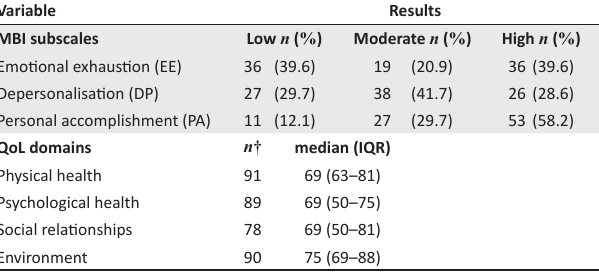
TABLE 1: Summary of the Maslach Burnout Inventory burnout subscales and the quality of life domains.